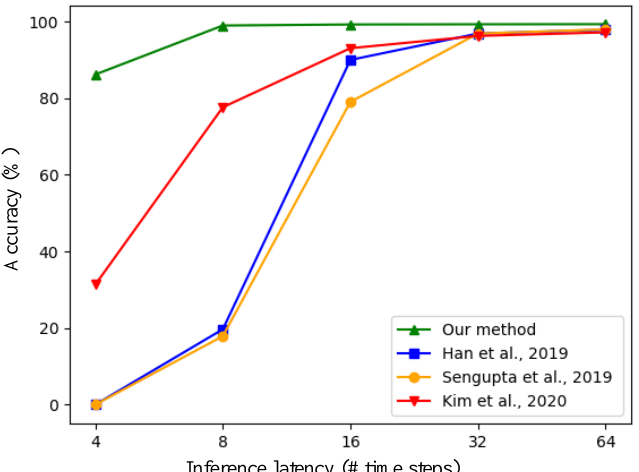
Figure 6. Performance comparison of the proposed method and other CNN–SNN conversion methods on the MNIST dataset [25–27].